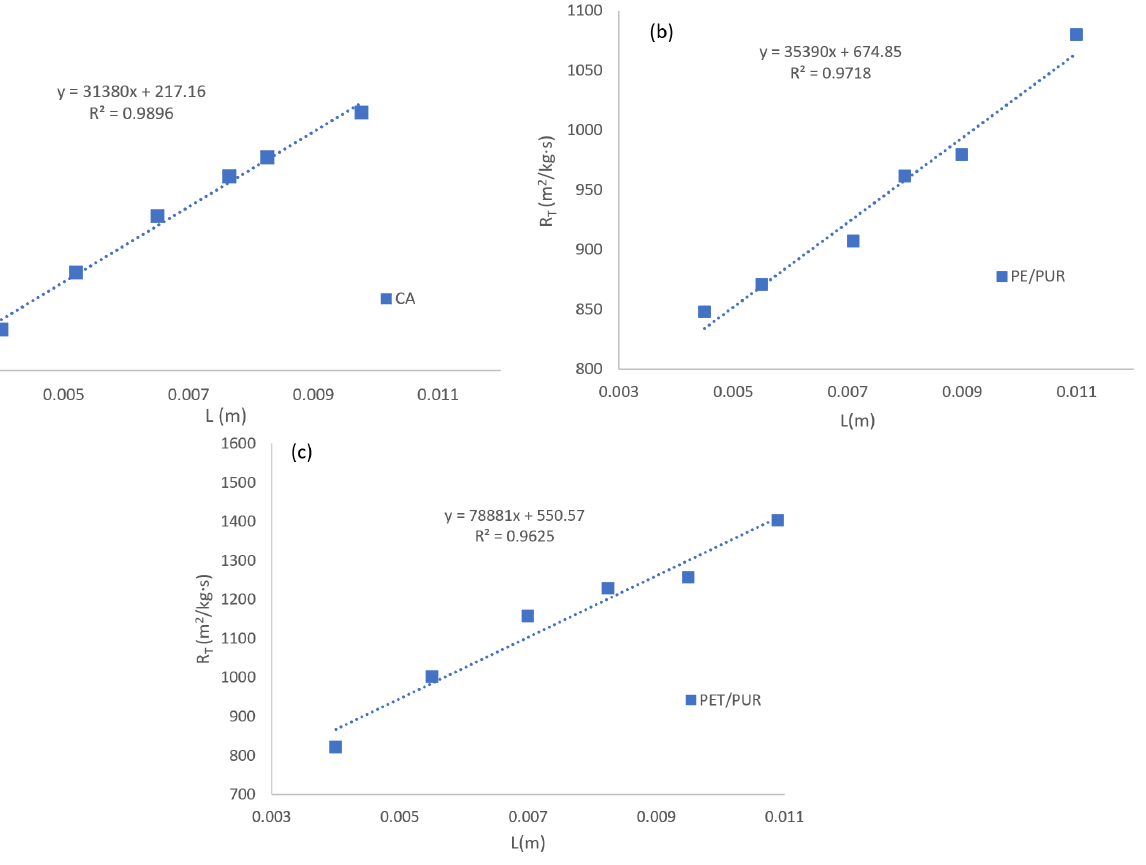
Figure 8. Total mass transfer resistances with various air gap heights ( a ) CA, ( b ) PE/PUR, ( c ) PET/PUR. ( c )